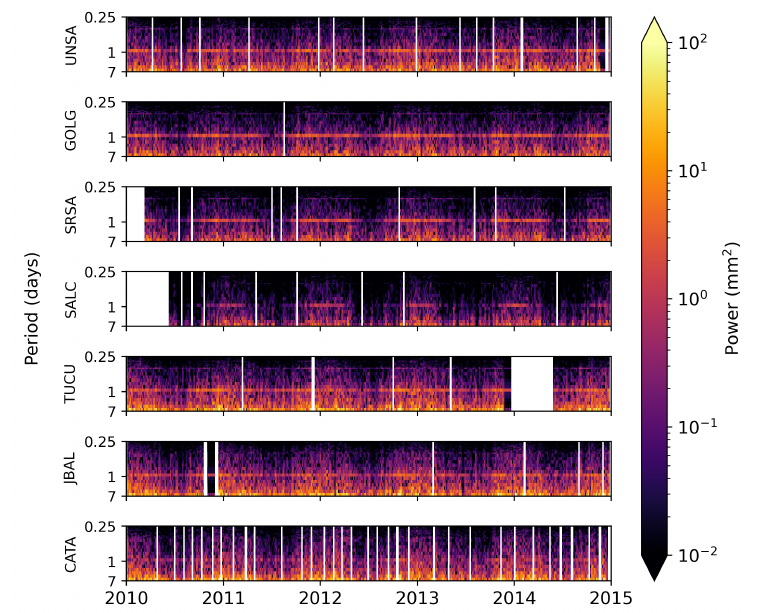
Figure 6. Spectral analysis of the stations along the E-W and N-S directions (Altitude asl: UNSA—1224 m, GOLG—2343 m, SRSA—3113 m, SALC—3799 m, TUCU—456 m, JBAL—381 m,